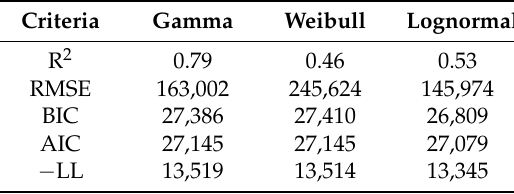
Table 8. Quantitative measures of model performance by GLM using the lasso penalization